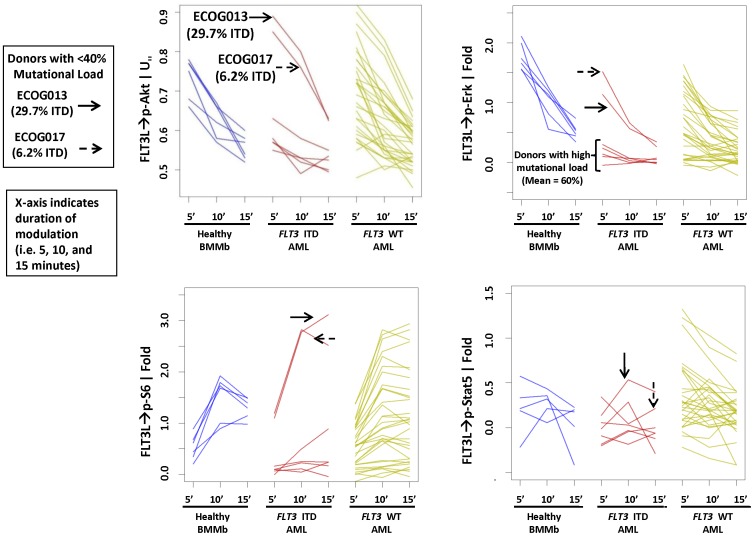
Muted FLT3L-induced signaling in FLT3 ITD samples.(A) FLT3 ITD samples demonstrate lower FLT3L-induced PI3K, RAS and STAT signaling. Time-course of FLT3L-induced signaling of p-S6 (lower left), p-ERK (upper right), p-AKT (upper left), and p-STAT5 (lower right) at 5, 10 and 15 min time points in healthy bone marrow myeloblasts (BMMb) (left), and leukemic blasts from AML donors with (middle) or without (right) FLT3 ITD mutation. Donors with low mutational load (<40%) are identified with an arrow.